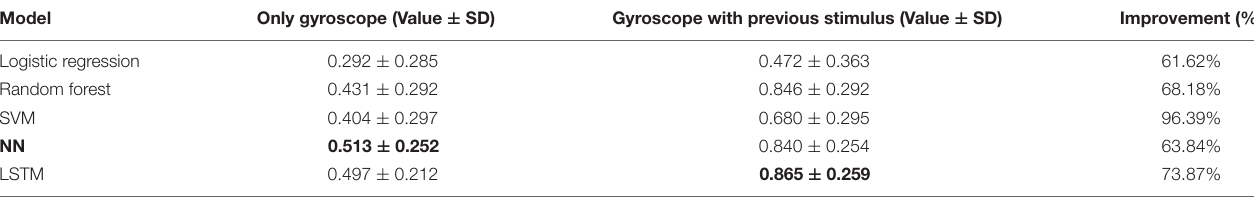
TABLE 8 | Performance in terms of “accuracy” comparison between Logistic Regression, Random Forest, NN, and SVM with two feature sets. Model Only gyroscope (Value ± SD) Gyroscope with previous stimulus (Value ± SD)